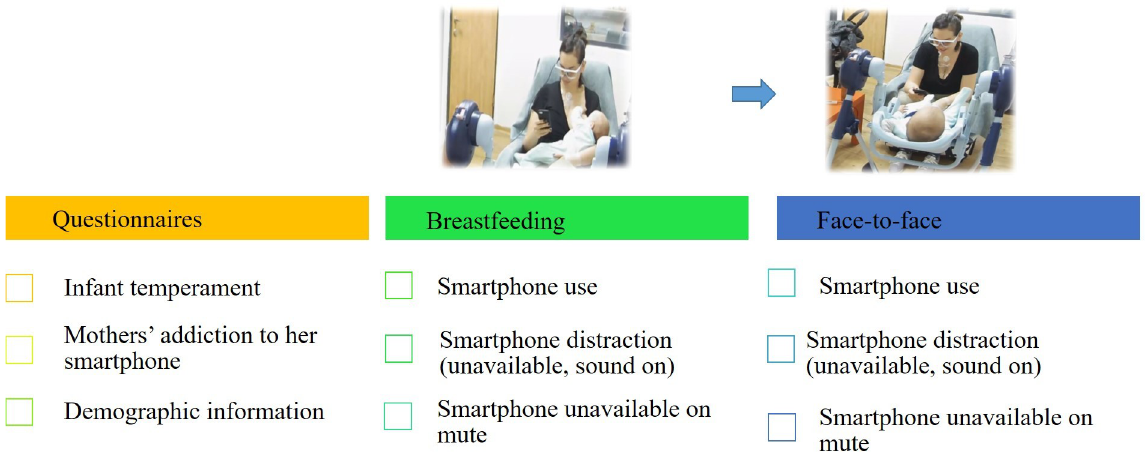
Fig 1. Procedure and experimental design. Initially, mothers’ filled in several self-report questionnaires, followed by two experimental phases in the lab (breastfeeding and face-to-face interactions). Each phase was comprised of three experimental smartphone conditions, each lasting 5 minutes. Through the lab study, mothers’ EDA, cardiac impedance and gaze fixation patterns were continuously recorded. The entire lab visit was also video-recorded from three angles.